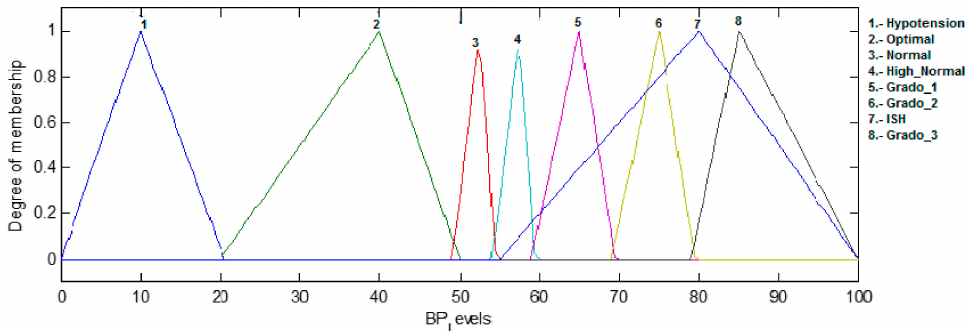
Figure 6. BP_Levels is the output of the fuzzy logic classifier 1.